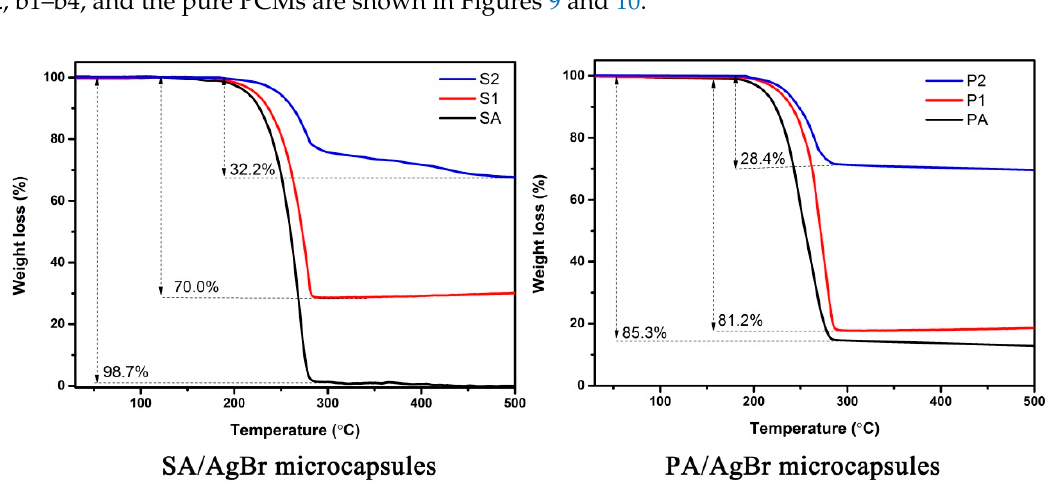
Table 4. Comparison of the encapsulation ratio of the micro/nanocapsules prepared in this work with that of other methods.